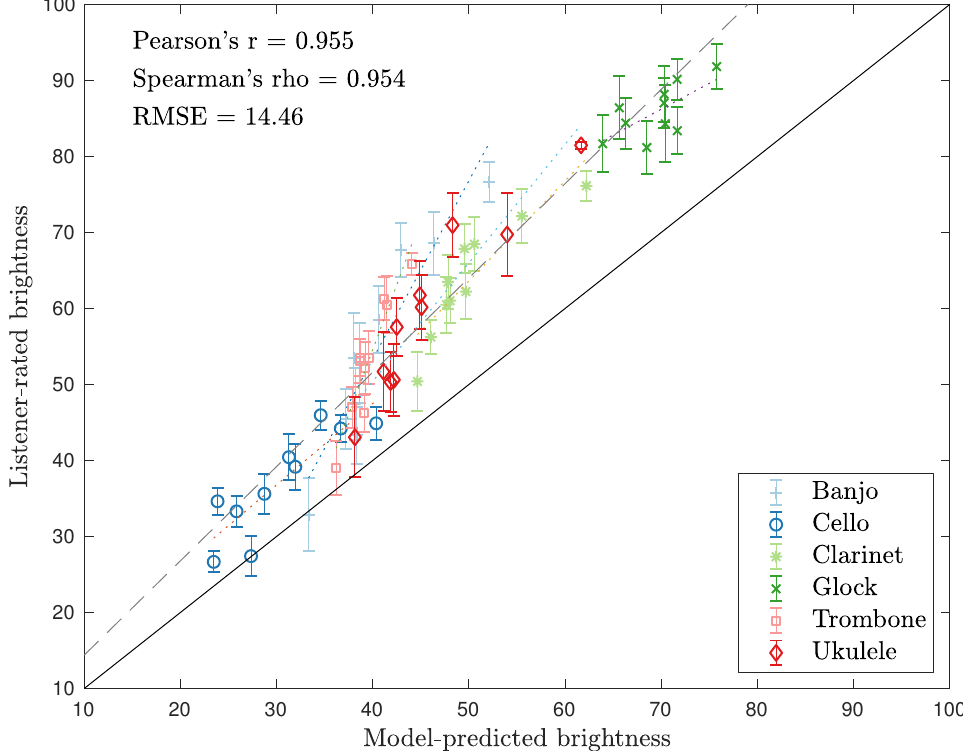
Figure 6. Validation brightness ratings against the model of brightness, colours indicating each source type. Coloured dotted lines represent the line of best fit for each source, and the grey dashed line is the overall line of best fit (Colour